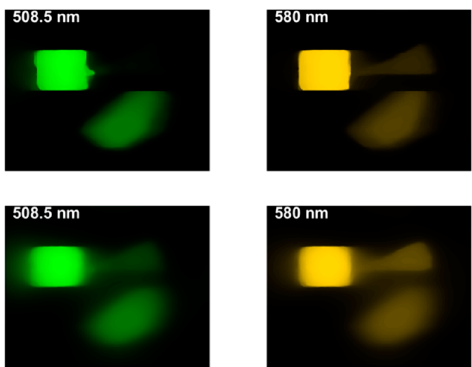
Figure 13. The effect of reconstruction for ( a ) the red triangle target using a range of ( b ) the regularizer parameter τ 0.01–0.5. The smaller the values of τ (e.g., 0.02 and 0.01) give better spectral reconstruction accuracy.